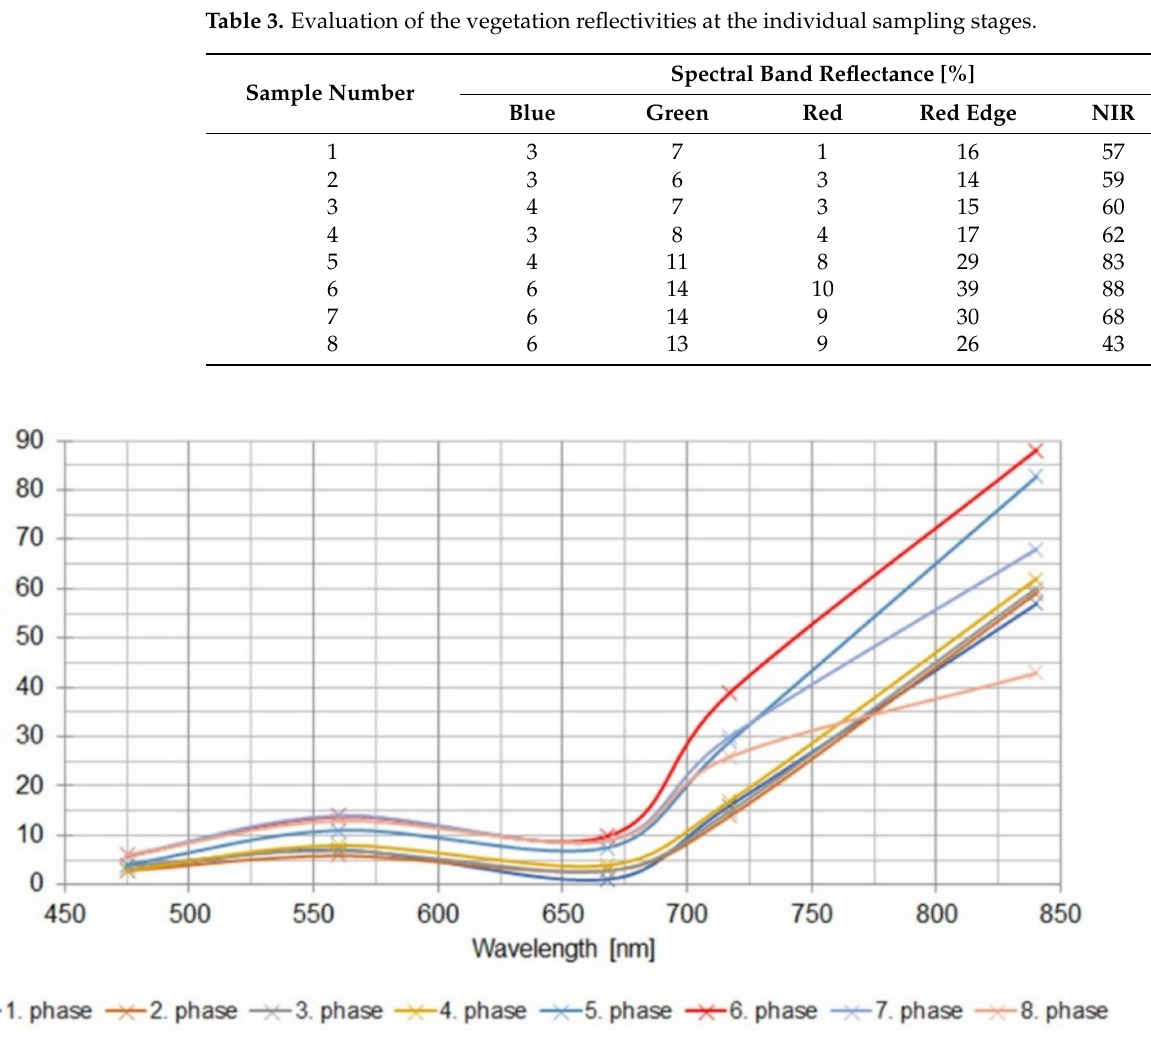
Figure 6. The reflectivity relationships at the individual wavelengths and sampling